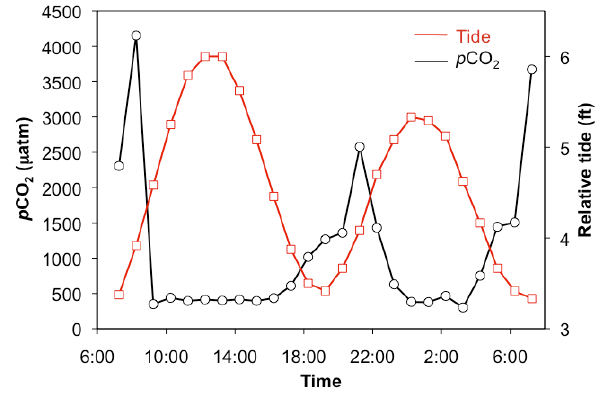
Example of a near-shore mangrove environment in Bermuda, which undergoes large diurnal fluctuations in seawater carbonate chemistry over diurnal cycles owing to tidal flushing (and pumping) and groundwater intrusion as well as changes in ecosys- tem metabolism (e.g., photosynthesis, respiration, calcification, and CaCO 3 dissolution) between night and day. Surface seawater p CO 2 (black line) and relative tide (red line) over a 24-h period are